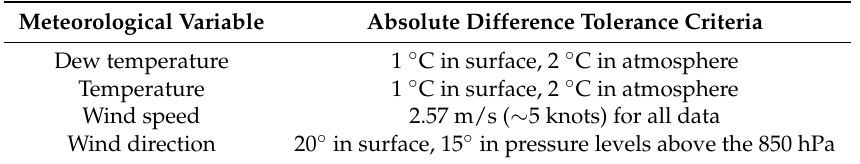
Table 4. Absolute difference tolerance criteria for simulated variables used by